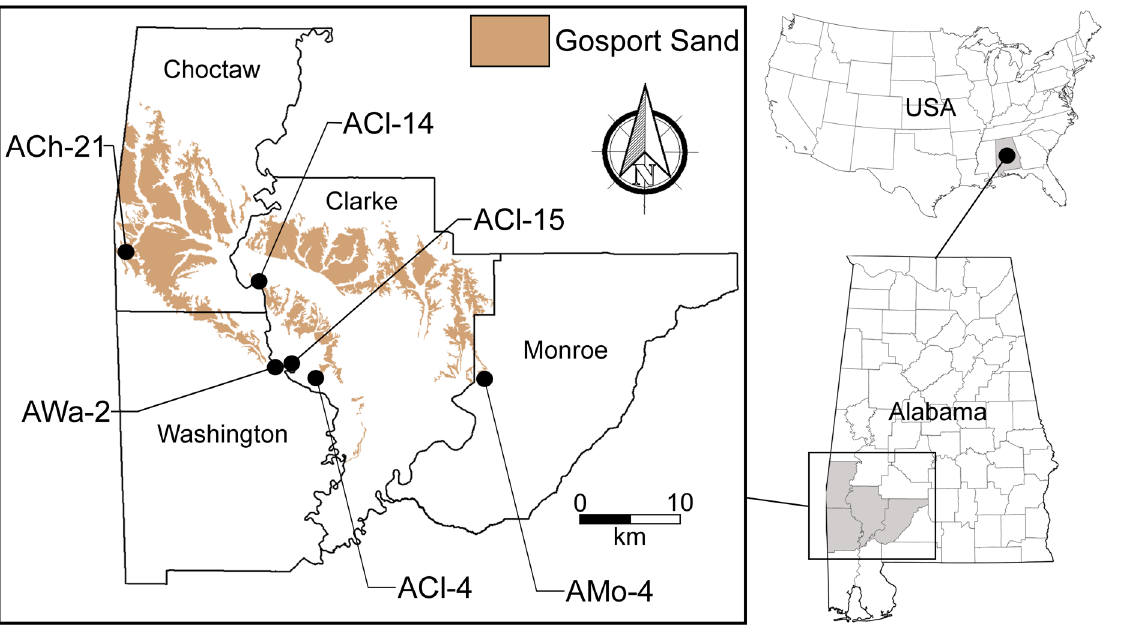
Fig. 4. Gosport Sand surface exposures in Alabama, with sampled localities indicated by closed